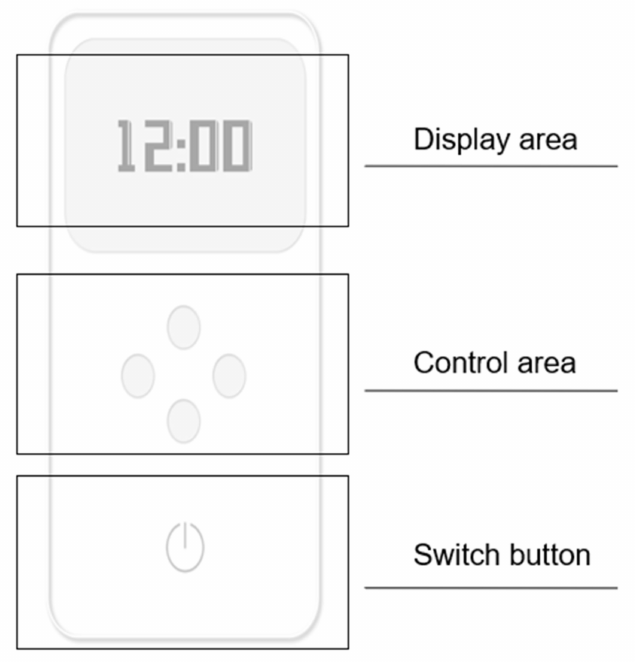
Figure 24. Function division of the control panel.